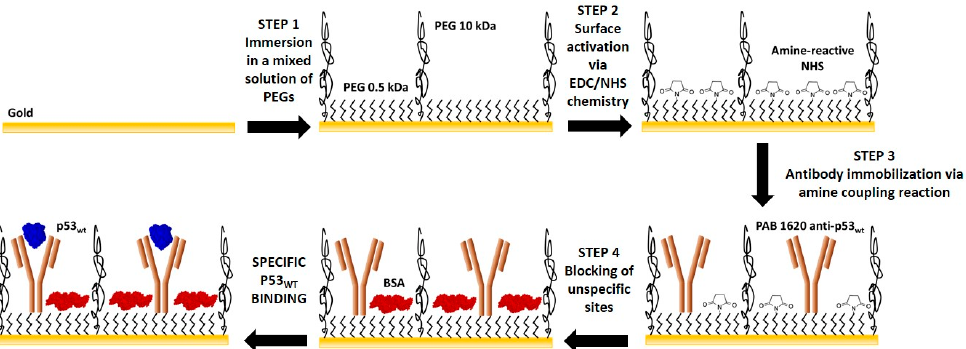
Figure 2. Main steps of gold extended-gate electrode biofunctionalization procedure (not to scale).